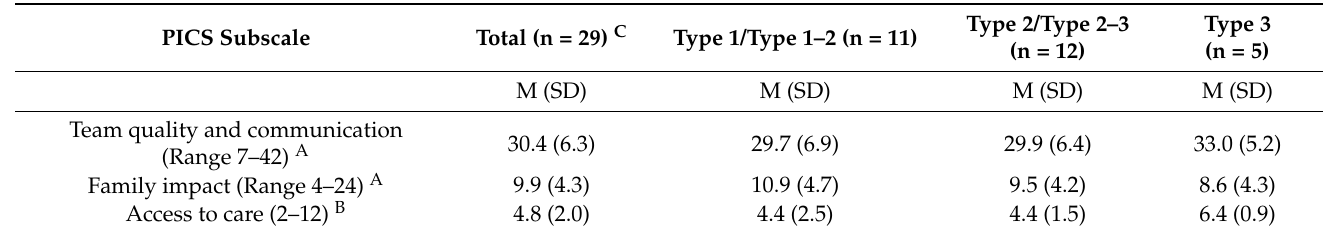
Table 3. Health care experiences in families with children with different SMA types (comparison of PICS subscales), n = 29.